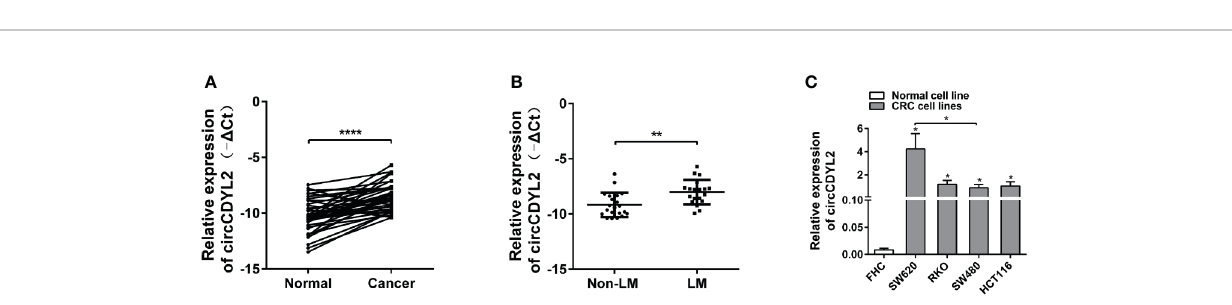
FIGURE 3 | CircCDYL2 was upregulated in CRC tissues and cell lines. (A) The relative expression levels of circCDYL2 were detected in 40 paired CRC tissues (Cancer) and matched adjacent non-cancerous colorectal mucosal tissues (Normal) by RT-qPCR. (B) CRC tissues with lymphatic metastasis ( n = 19) had higher circCDYL2 expression levels than CRC tissues without lymphatic metastasis ( n = 21). (C) CircCDYL2 was overexpressed in four CRC cell lines compared with the normal human colonic cell line FHC. * p < 0.05, ** p < 0.01, **** p < 0.0001.